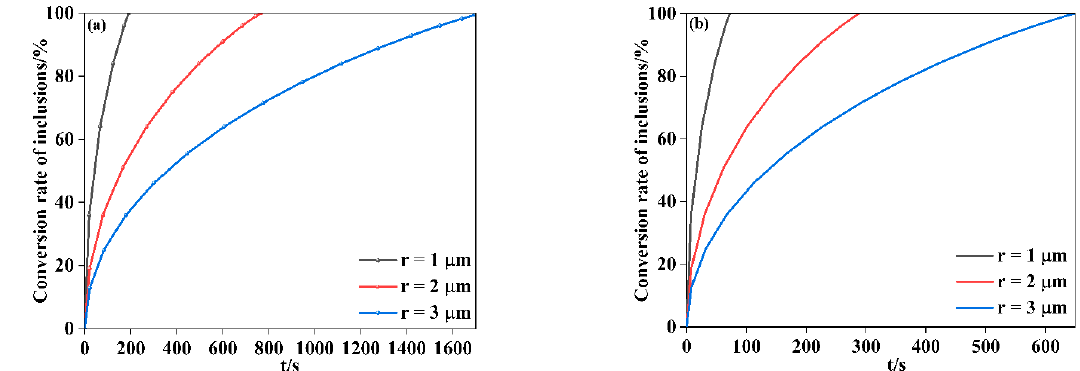
Figure 11. Modification process of inclusions with different particle sizes (( a ). Al 2 O 3 modified into MA; ( b ). MA is modified into MgO).